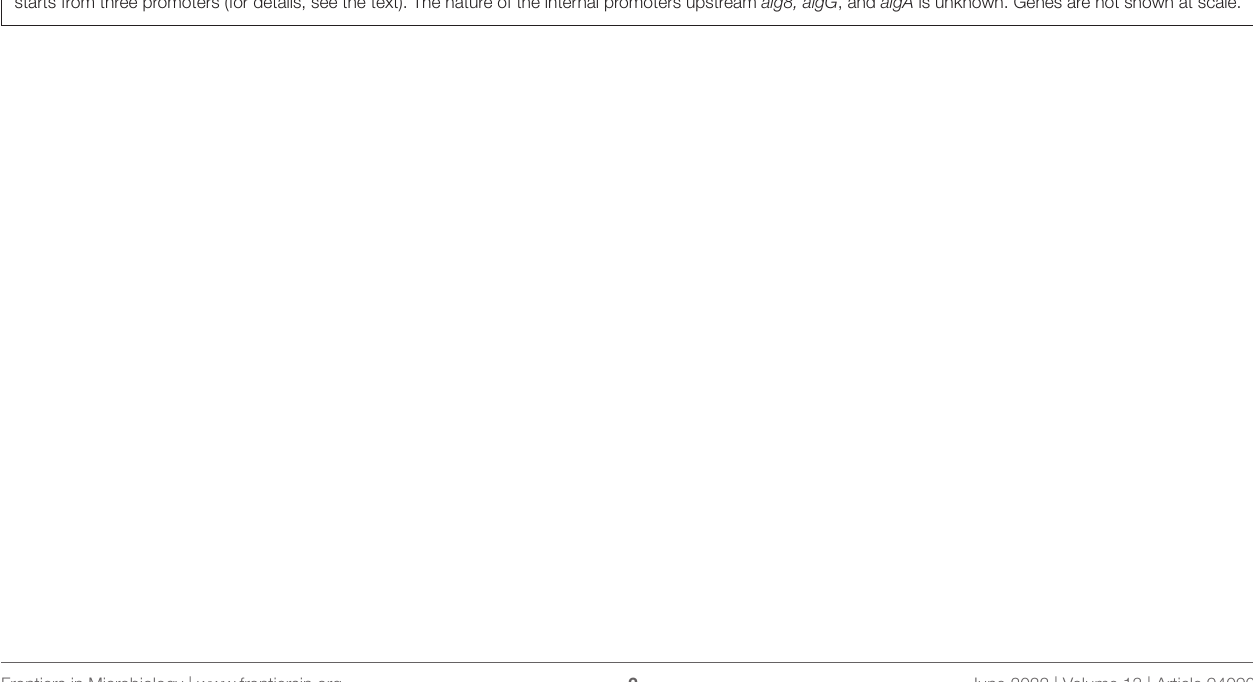
Frontiers in Microbiology | www.frontiersin.org